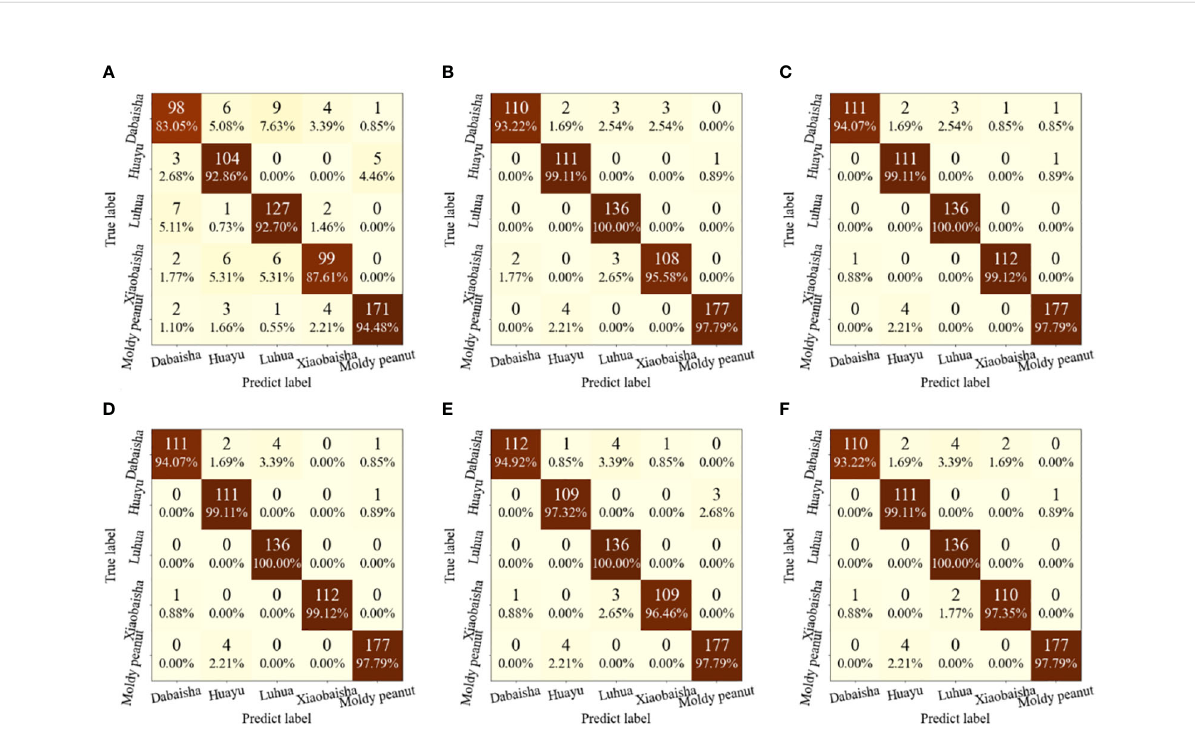
FIGURE 9 Confusion matrix for the training set of SEL. (A) RAW-Stack; (B) MF-Stack (C) MF-XGBoost-SEL; (D) MF-LightGBM-SEL; (E) MF-CatBoost-SEL; (F)